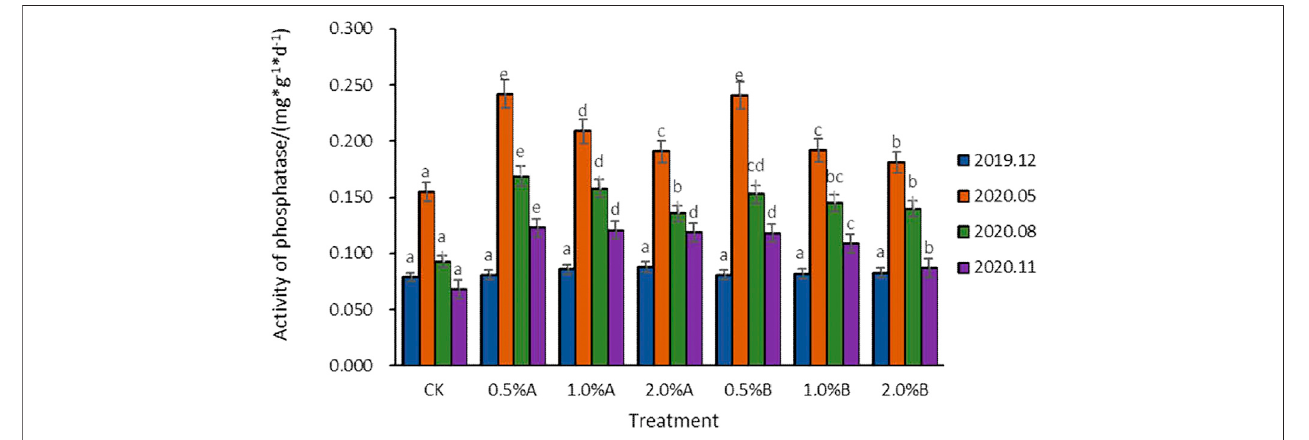
FIGURE 4 | Variation of phosphatase activity with time in each